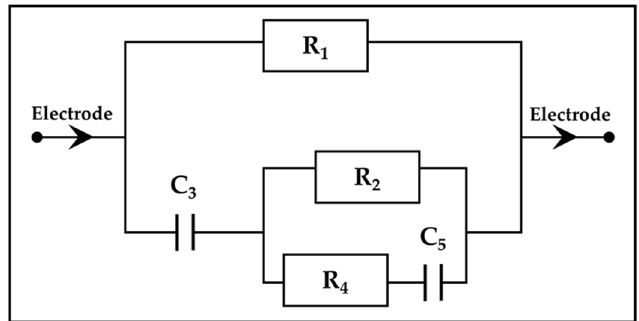
Figure 3. Use of the double-shell electrical model. R 1 represents the cell wall resistance and the ECF , R 2 represents the cytoplasmic resistance, C 3 represents the cell membrane capacitance, R 4 represents the vacuole resistance, and C 5 represents the vacuolar membrane capacitance.